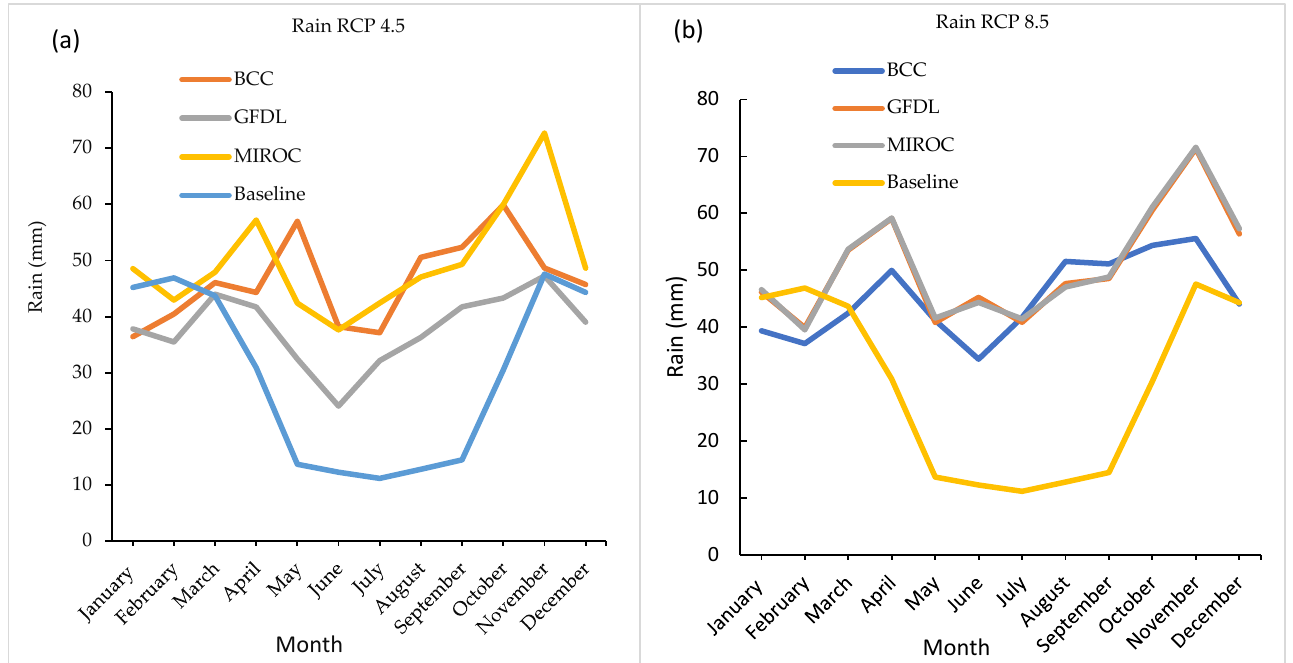
Figure 4. Monthly average rainfall for the two 30-year future periods compared to 31 years of baseline data, ( a ) RCP 4.5 and ( b ) RCP 8.5.